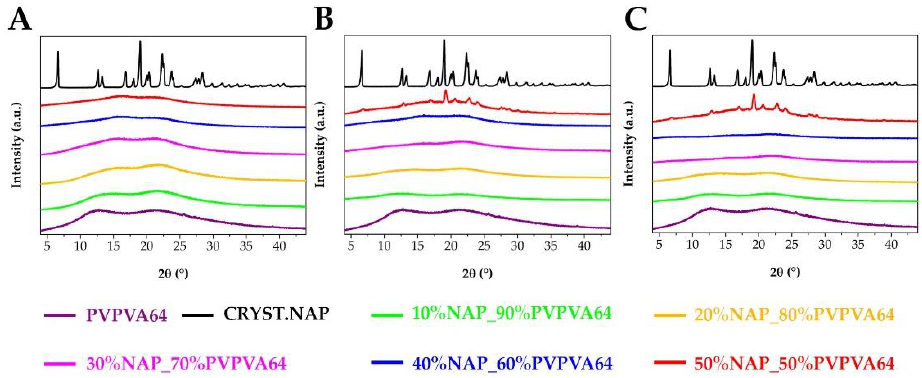
Figure 12. XRPD patterns of the ASD samples before storage ( A ), after 1 day storage ( B ), and after 1 week storage ( C ).